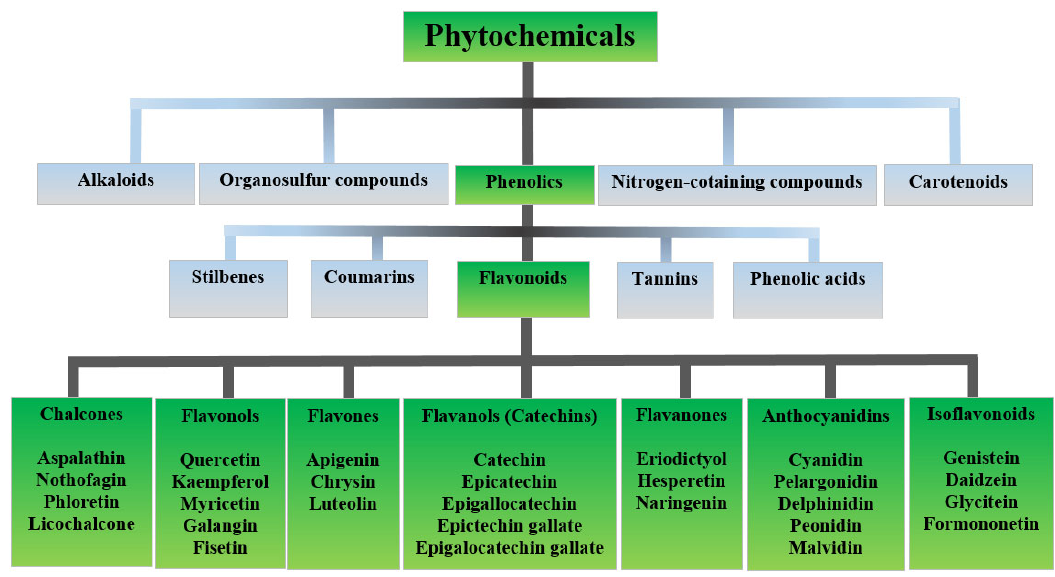
Figure 1. Classification of dietary phytochemicals with emphasis on the flavonoid group (Adapted Figure 1. Classi fi cation of dietary phytochemicals with emphasis on the fl avonoid group (Adapted from from [7]).